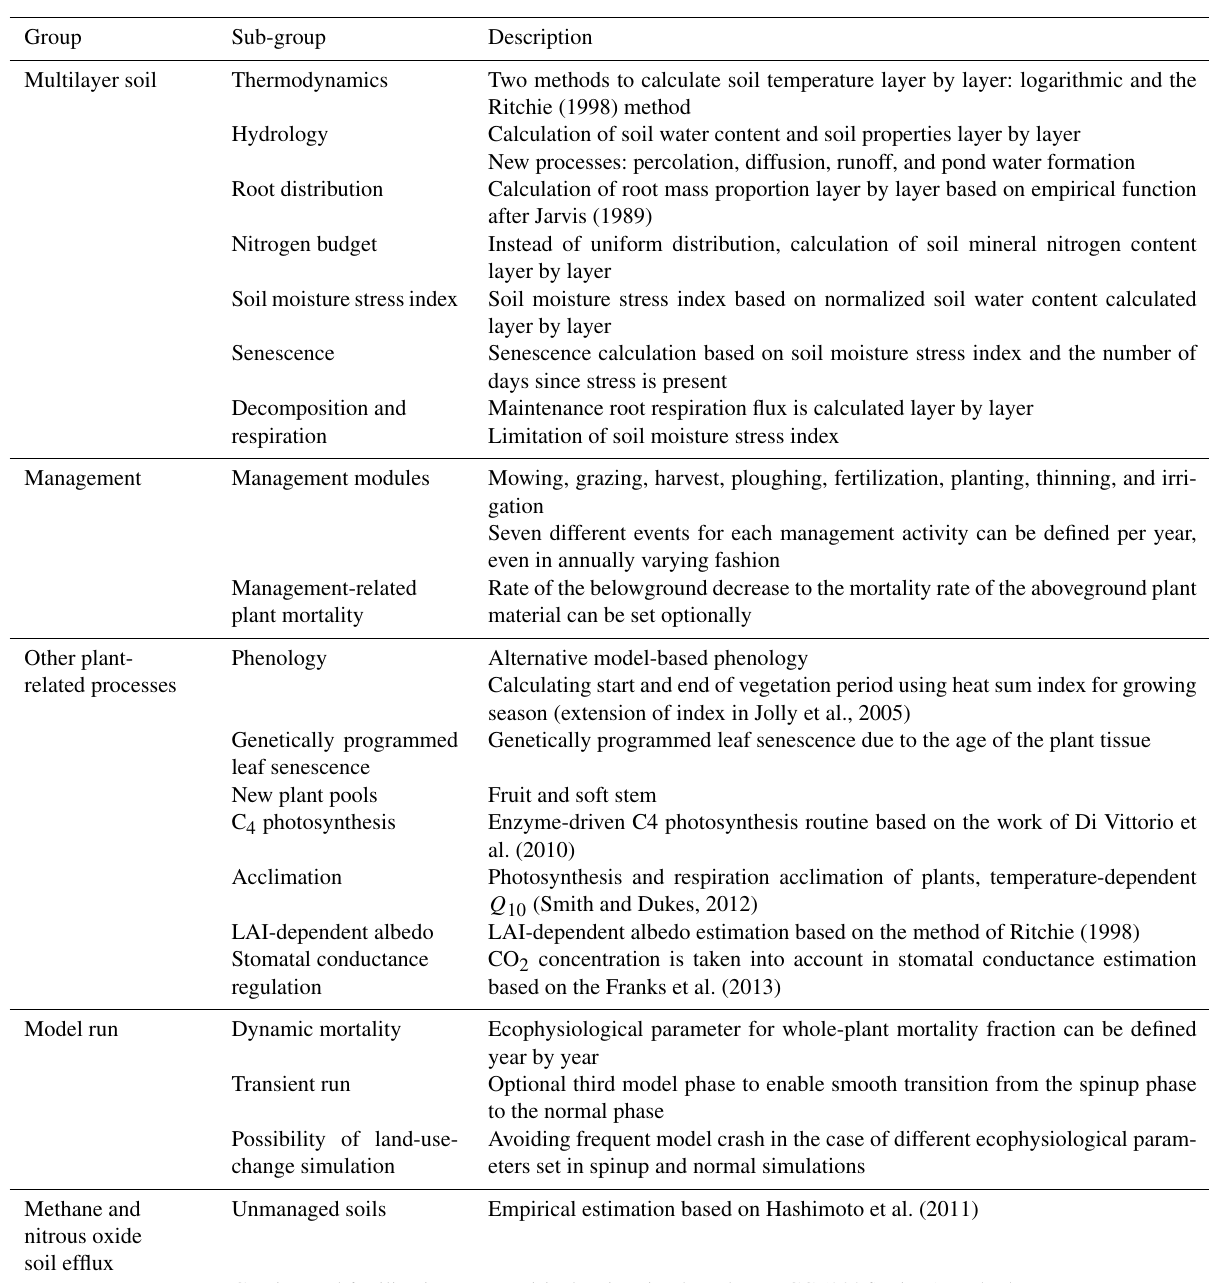
Table 1. Summary of model adjustments. Group refers to major processes represented by collection of modules in Biome-BGCMuSo, while sub-group refers to specific